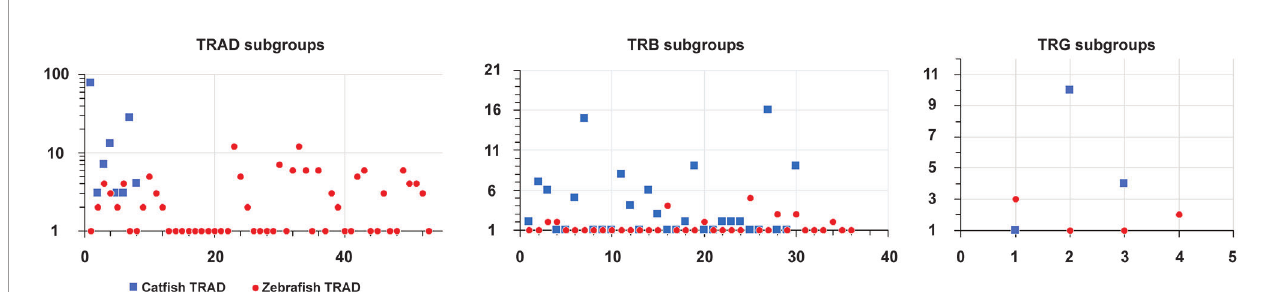
FIGURE 3 | Comparison of the number of genes within each subgroup in the cat fi sh and zebra fi sh TRAD, TRAB and TRG loci. The diagram depicts the number of subgroups and the number of genes within each subgroup. The subgroup numbers are indicated along the x-axis and the number of genes on the y-axis. Note that the y-axis for the TRAD locus is on a